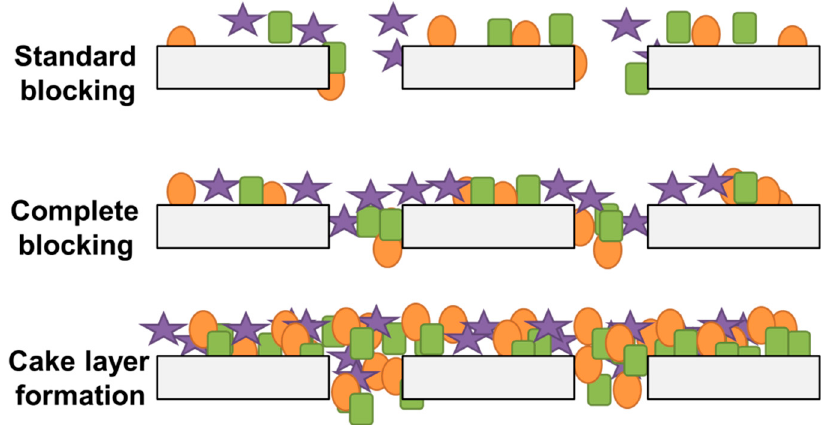
Figure 2. Membrane fouling mechanisms in microfiltration. Standard clocking d foulant < d pore , complete blocking d foulant > d pore , cake layer formation d foulant > d pore where d is membrane pore diameter.